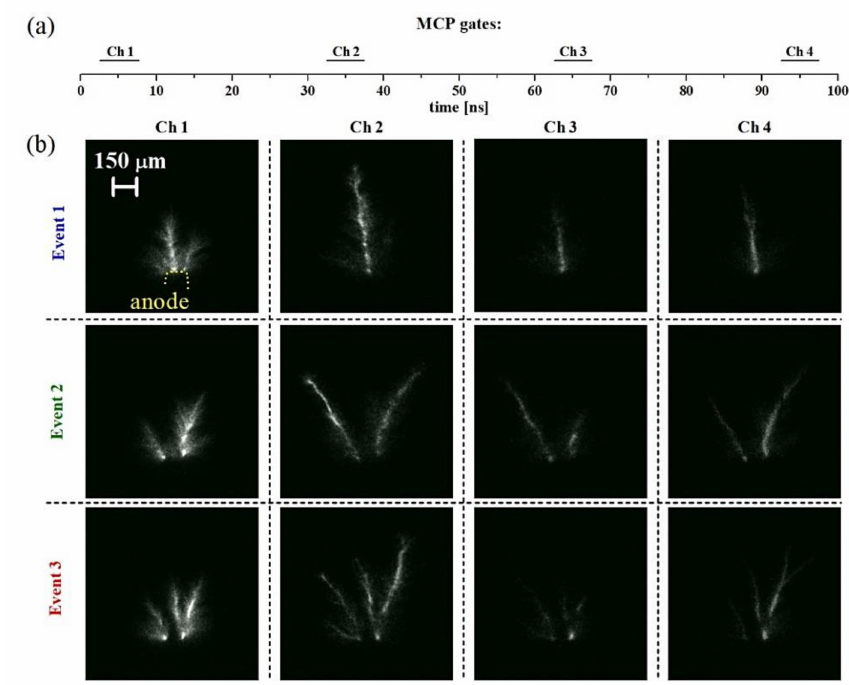
Figure 12. Case study C; image sequences obtained using the discharge emission that passes through the λ c = 532 nm interference filter. Horizontal bars in ( a ) labelled as Ch1–Ch4 illustrate the timing of the Ch1–Ch4 MCP gates with respect to the onset (time t = 0 ns) of the HV pulse. Images in panel ( b ) show the evolution of selected events during the primary and first three reflected HV pulses acquired by using appropriately delayed Ch1–Ch4 MCP gates of equal duration of 5 ns.